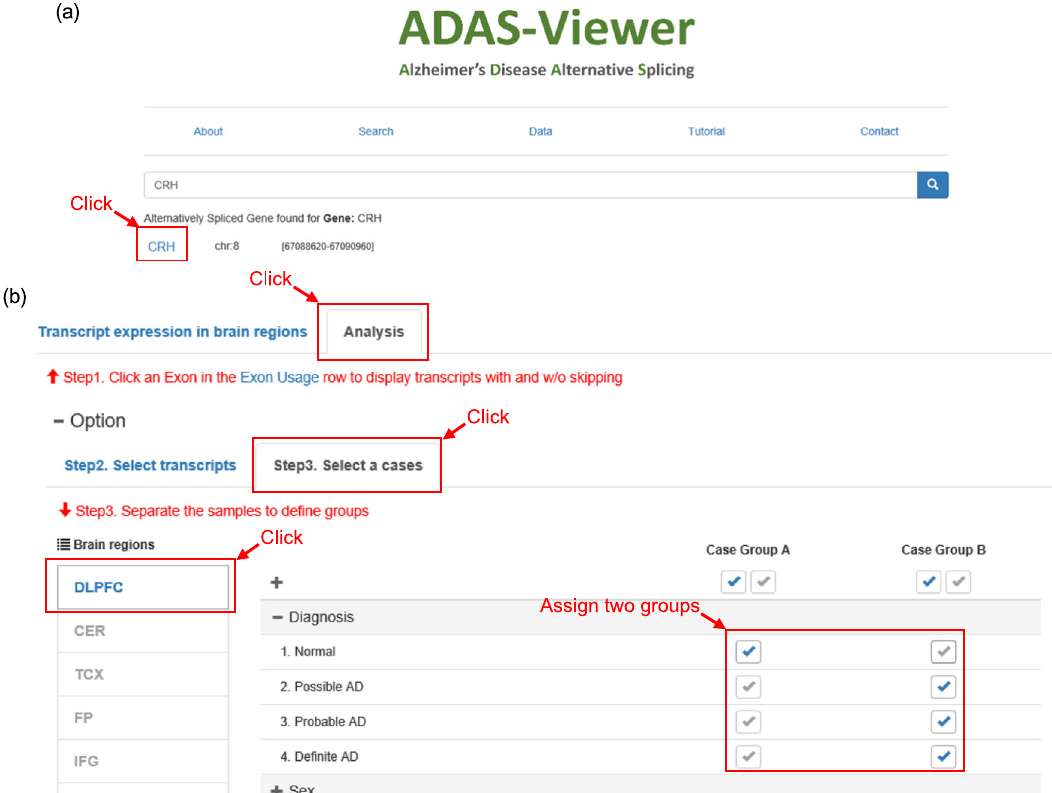
Fig. 3 Search page and Analysis tab of ADAS -viewer. a This example searches for the gene CRH , which can be further investigated by clicking the result hyperlink. b In the Analysis tab, users may compare data between groups, in this example between normal cases (Group A) and AD cases (Group